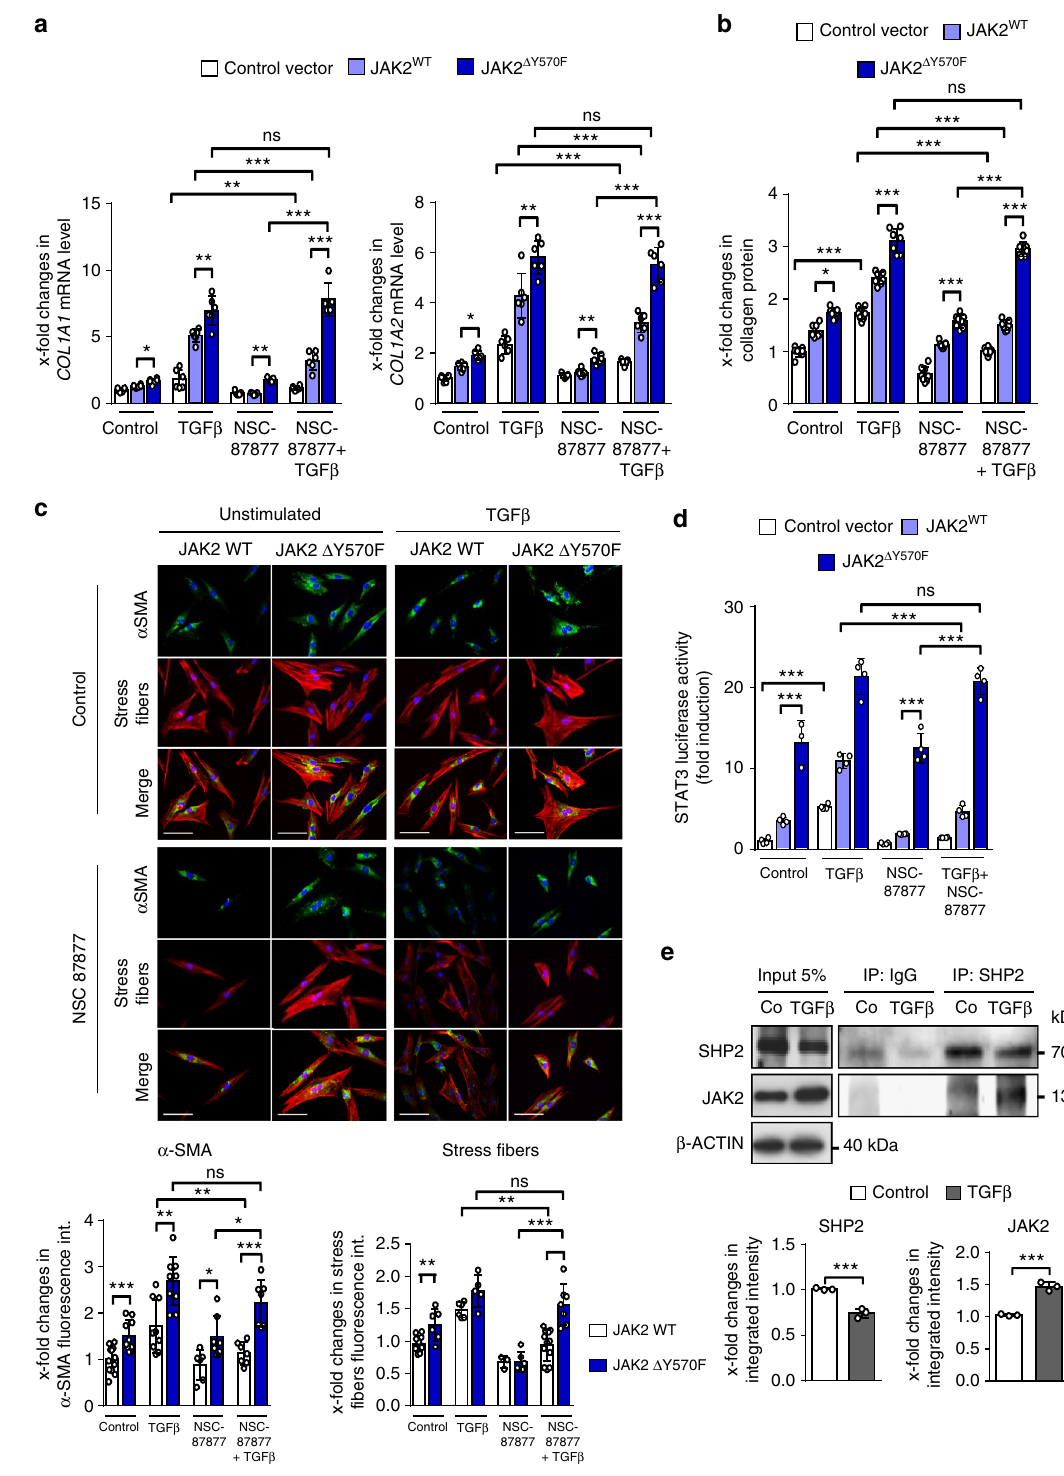
Fig. 7 Overexpression of JAK2 Δ Y570F prevents the inhibitory effects of SHP2 inhibitors on TGF β -induced fi broblast activation. a mRNA levels of COL1A1 and COL1A2 (TGF β 10 ng/ml for 24 h) ( n ≥ 5). b Release of collagen protein (TGF β 10 ng/ml for 24 h) ( n ≥ 6). c Representative images of immuno fl uorescence stainings for α -SMA and stress fi ber at 400-fold magni fi cation and respective quanti fi cations (TGF β 10 ng/ml for 24 h) ( n ≥ 6). Horizontal scale bar, 500 μ m. d STAT3 reporter Assay upon JAK2 WT and Y570F mutant overexpression. Cells were treated with TGF β (10 ng/ml for 6 h) and NSC-87877 (100 µ M) ( n ≥ 4). e Co-immunoprecipitation and respective quanti fi cations of endogenous JAK2 with endogenous SHP2 in human fi broblasts stimulated with TGF β (10 ng/ml for 30 ′ ) ( n = 3). Results shown are representative of ≥ 3 independent experiments. All data are presented as median± s.e.m. The p values are expressed as follows: 0.05 > p > 0.01*; 0.01 > p > 0.001**; p < 0.001***; ns: not signi fi cant. Signi fi cance was determined by Mann – Whitney